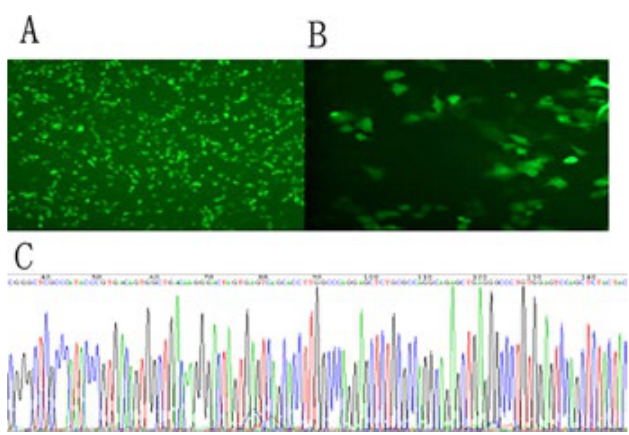
FIGURE 1 - Determination of lentivirus titer and identification of recombinant plasmid products by sequencing. A: The recombinant plasmid expressing si-MALAT1 was observed under fluorescence microscope (40x); B: The plasmid expressing empty vector was observed under fluorescence microscope; C: Identification of recombinant plasmid products by sequencing .